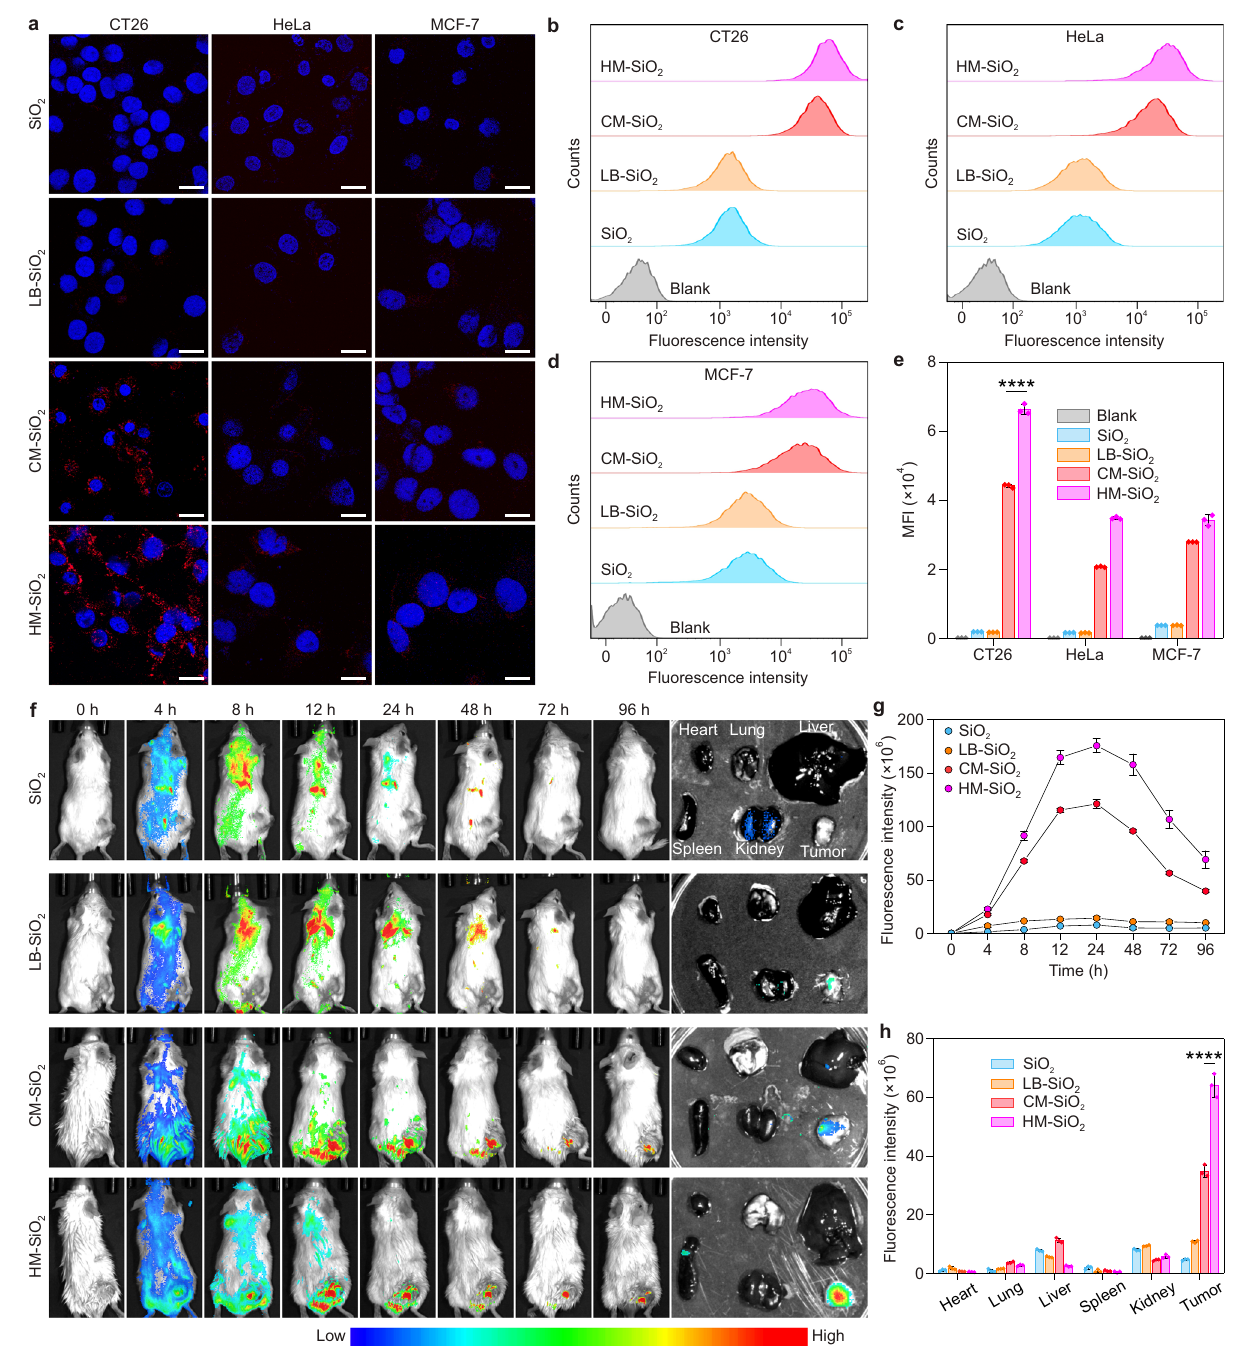
Fig. 5 | Investigation of the homologous targeting capabilities of HM-SiO 2 NPs in vitro and tumor targeting in vivo. a Typical CLSM images of three cancer cell lines (CT26,HeLa, and MCF-7)incubatedwithSiO 2 NPs, LB-SiO 2 NPs, CM-SiO 2 NPs, and HM-SiO 2 NPs for 4 h. Blue, cell nuclei stained with 4 ′ ,6-diamidino-2-pheny- lindole(DAPI);red,Cy5-labeled SiO 2 cores.Scalebars,20 μ m. b – d Flowcytometric analysis of CT26 cells ( b ), HeLa cells ( c ), and MCF-7 cells ( d ) after 4 h incubation with blank solution, SiO 2 NPs, LB-SiO 2 NPs, CM-SiO 2 NPs, and HM-SiO 2 NPs. e Quanti fi cation of the mean fl uorescence intensities (MFI) for the three cell lines (CT26, HeLa, and MCF-7). Data represent the mean±s.d. ( n =3 biologically inde- pendent cells). f Left panel: representative in vivo fl uorescence images of CT26 tumor-bearingmiceatdifferenttimepointsafterintravenousinjectionofSiO 2 NPs,